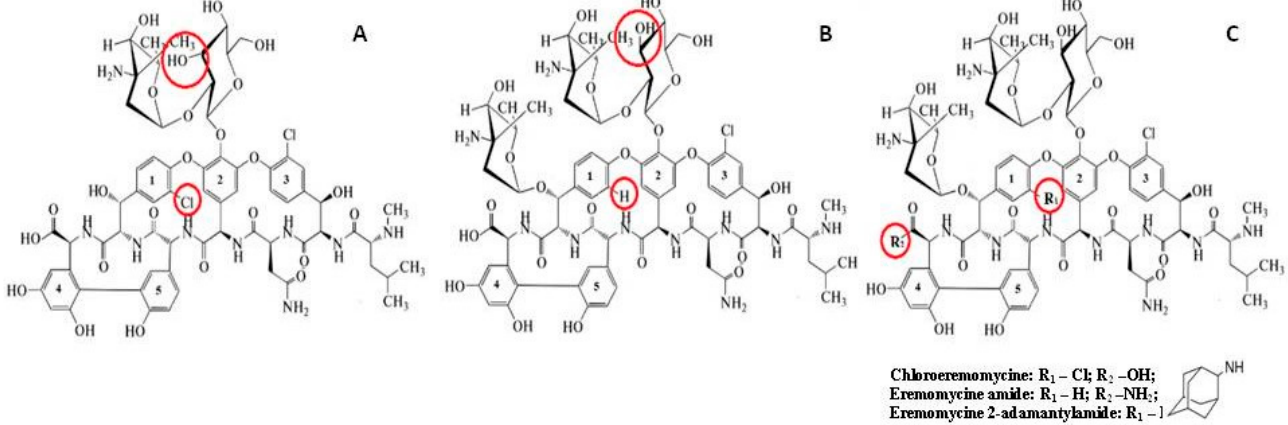
Figure 1. Chemical structures of vancomycin ( A ), eremomycin ( B ), and eremomycin derivatives used in this work ( C ). Structural differences are highlighted in red.